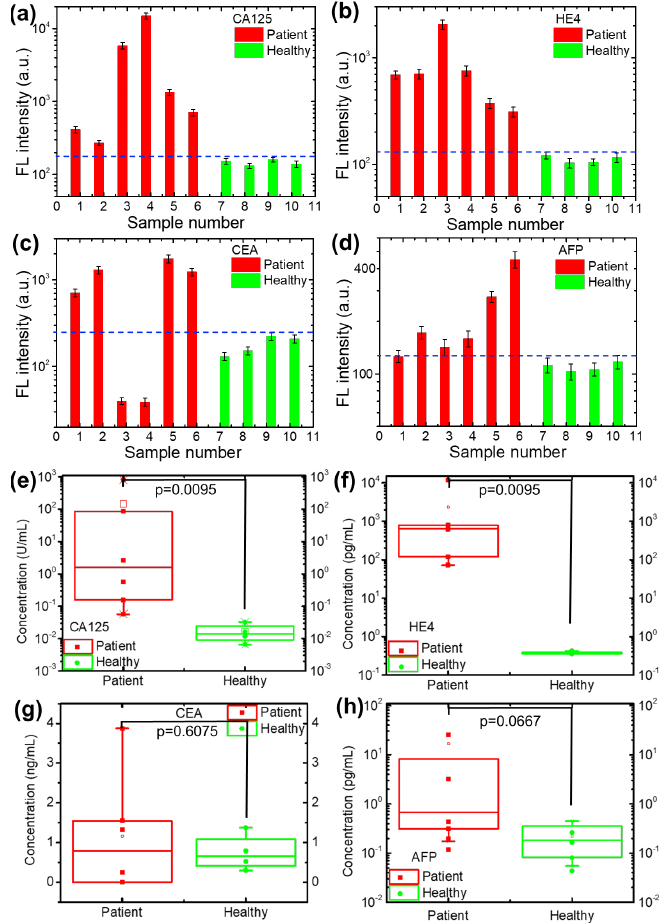
Figure 6. The detected results of six ovarian cancer patients and four healthy people: ( a ) CA125, ( b ) HE4, ( c ) CEA and ( d ) AFP. The blue dotted lines are the highest detection values of the biomarkers from healthy people. The statistical comparison of detected ( e ) CA125, ( f ) HE4, ( g ) CEA and ( h ) AFP in our lab between the ovarian tumor/cancer patients and healthy people.